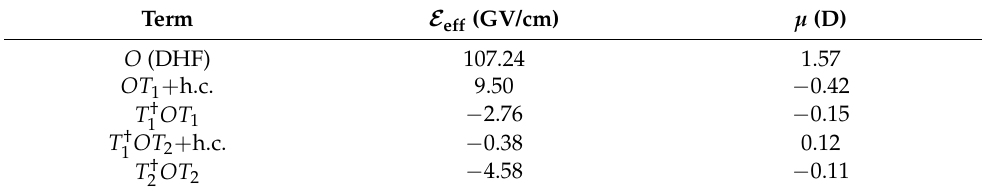
Table 3. Contributions from the individual relativistic coupled-cluster (RCC) terms to E eff (in GV/cm), µ (in D), and W s (in kHz) from both the linear and bent geometries of HgOH. O denotes the operator corresponding to the properties and h.c. means hermitian conjugate. Note that for the PDM, the term corresponding to the DHF contribution also accounts for the nuclear contribution in